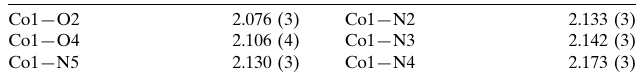
Selected bond lengths (A˚ ).